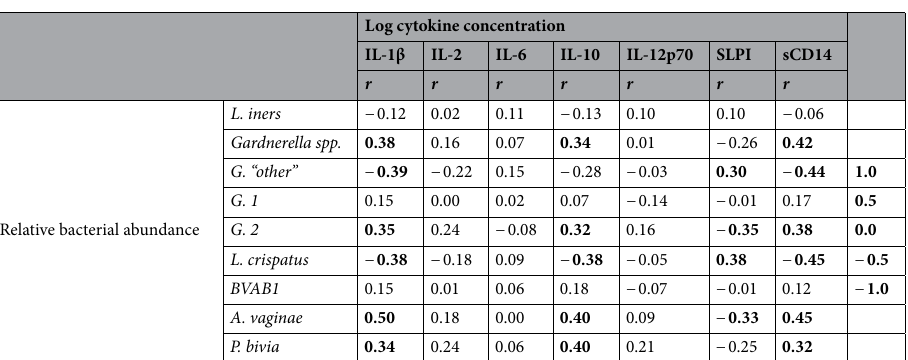
Table 2. Correlation between key relative bacterial abundances and log cytokine concentrations, represented as Spearman rank-order coefficients ( rho ). Bolded coefficients represent moderate correlation (i.e., |.3| to |.5|) between bacterial abundance and cytokine concentration and with p < 0.001, adjusted for multiple comparisons by Bonferroni